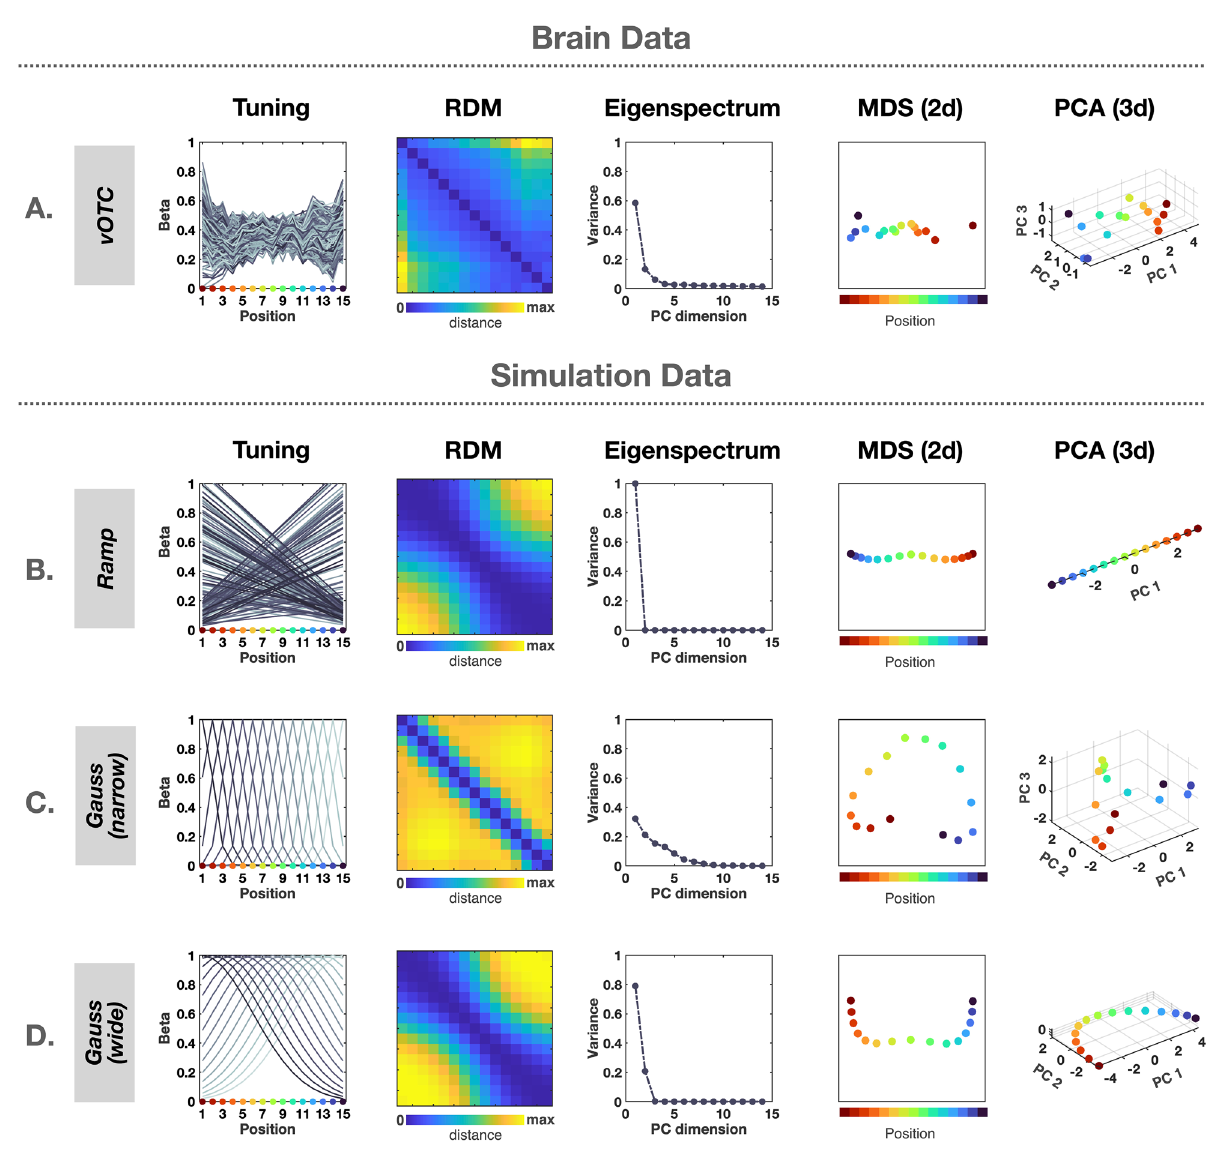
distances between conditions (RDM), how much variance is explained by each principal component (eigenspectrum), and visualization of representational geometry in the population (MDS (2d) and PCA (3d)). ( B – D ) Simulation idealized voxel tunings and representational geometry. The ramp-shaped tuning ( B ) shows one-dimension feature space with a perfectly linear trajectory, whereas the narrow Gaussian tuning (sigma = 1, C ) shows much higher feature dimension with a cardioid-like trajectory. However, the wide Gaussian tuning (sigma = 10, D ) showed similar representational geometry to the ramp-shaped